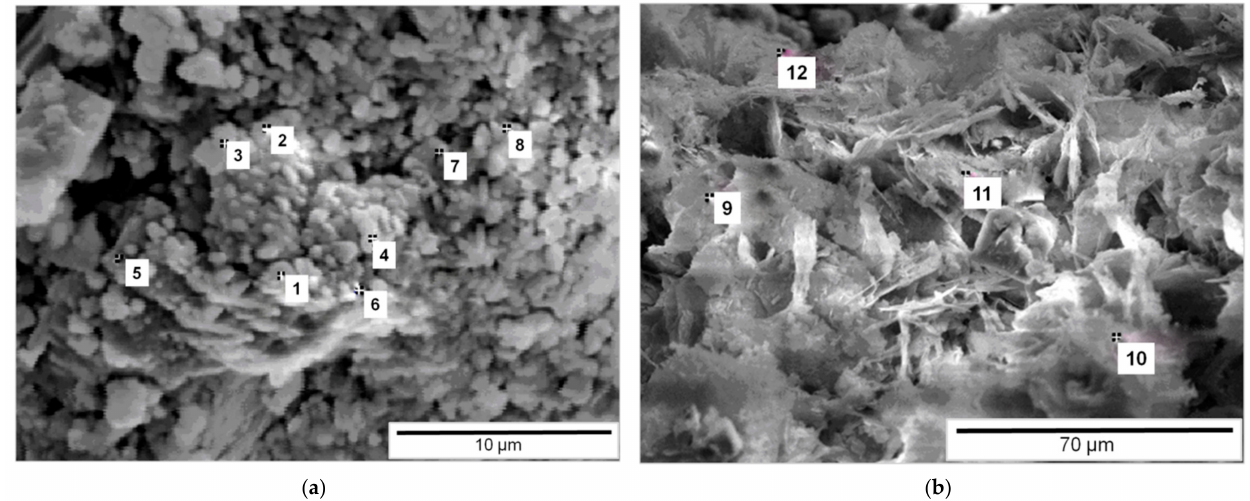
Figure 13. SEM image (1–12 spectrum): biofilm with spherical secretions ( a ), and plate-shaped biofilm ( b